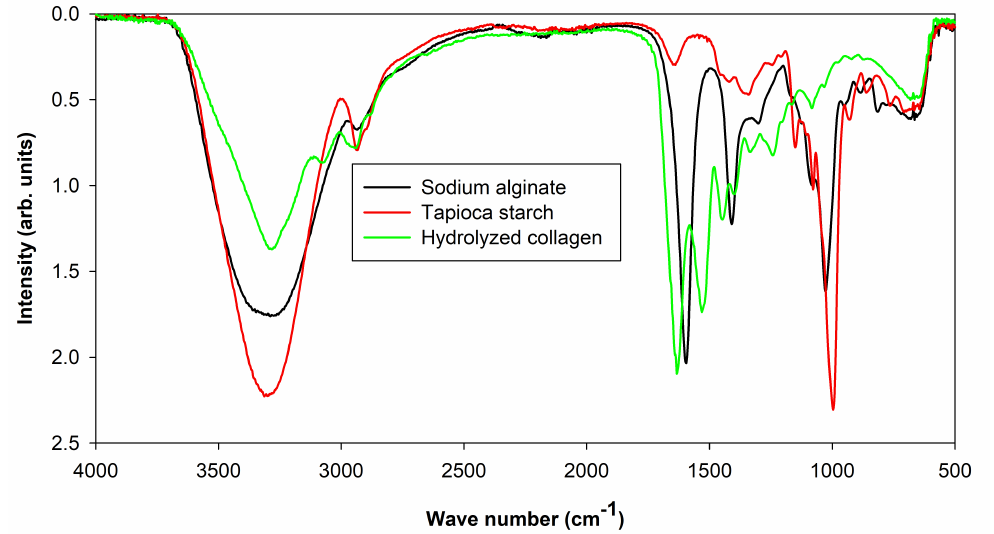
Figure 1. FTIR spectra of film-forming materials: sodium alginate( ), tapioca starch ( ), hydrolyzed collagen (